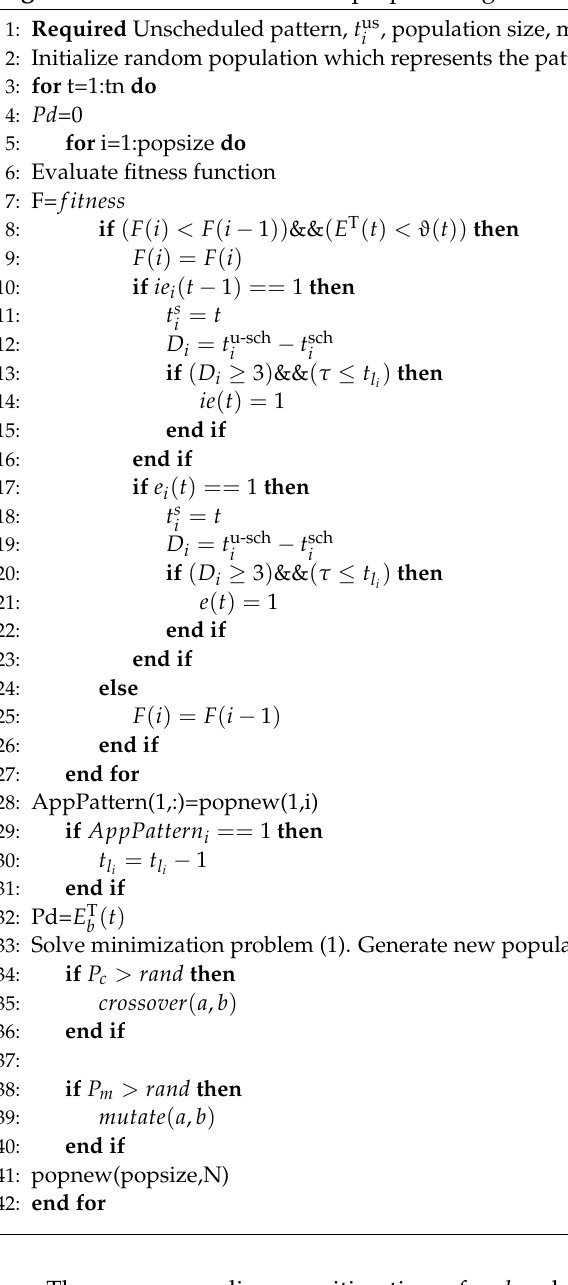
Algorithm 2 Pseudo code of the proposed algorithm for el and iel